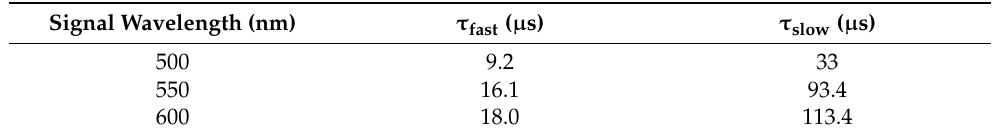
Table 1. PL decay lifetimes (fast and slow components) of Ag NCs: GP 4.5Ag sample under 405 nm excitation, and detection at 500, 550, and 600 nm.